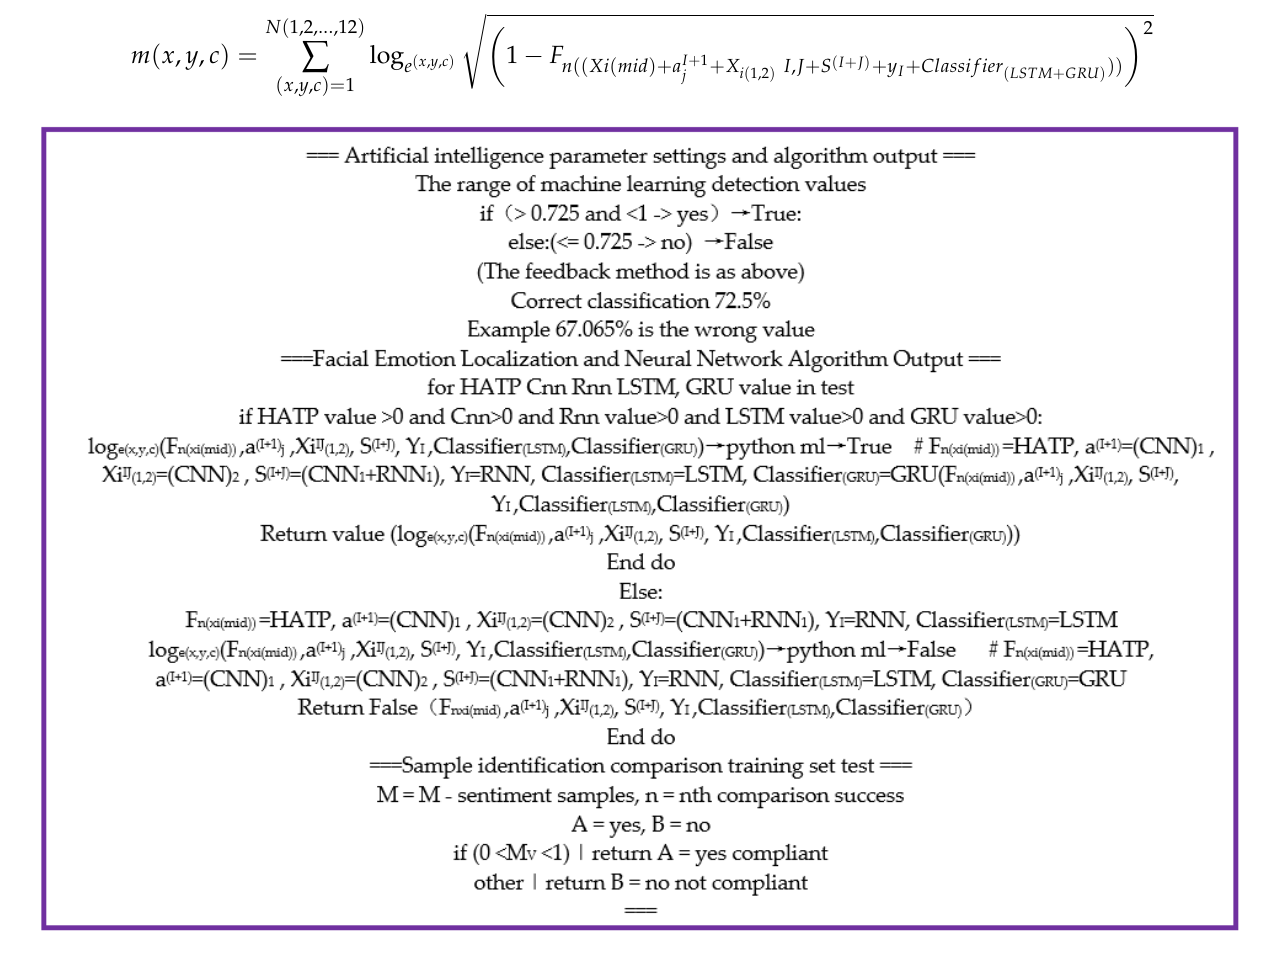
Figure 25. The output of the improved machine learning algorithm.